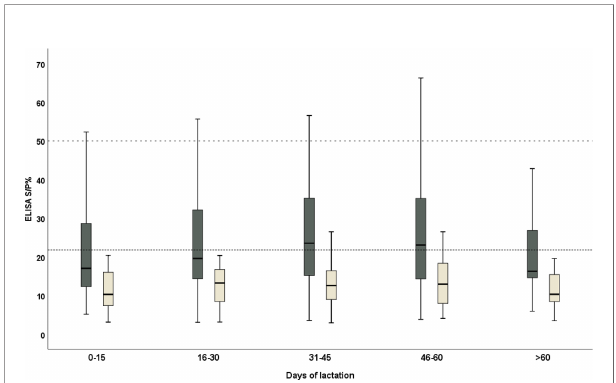
FIGURE 2 | The distribution trend of the ELISA S/P% values of serum (black) and milk (yellow) samples of the domestic donkeys during the lactation. The cutoff values for the anti- T. gondii IgG were 50 (dashed line) and 21.8 (dotted line) in the serum and milk samples and were considered positive,